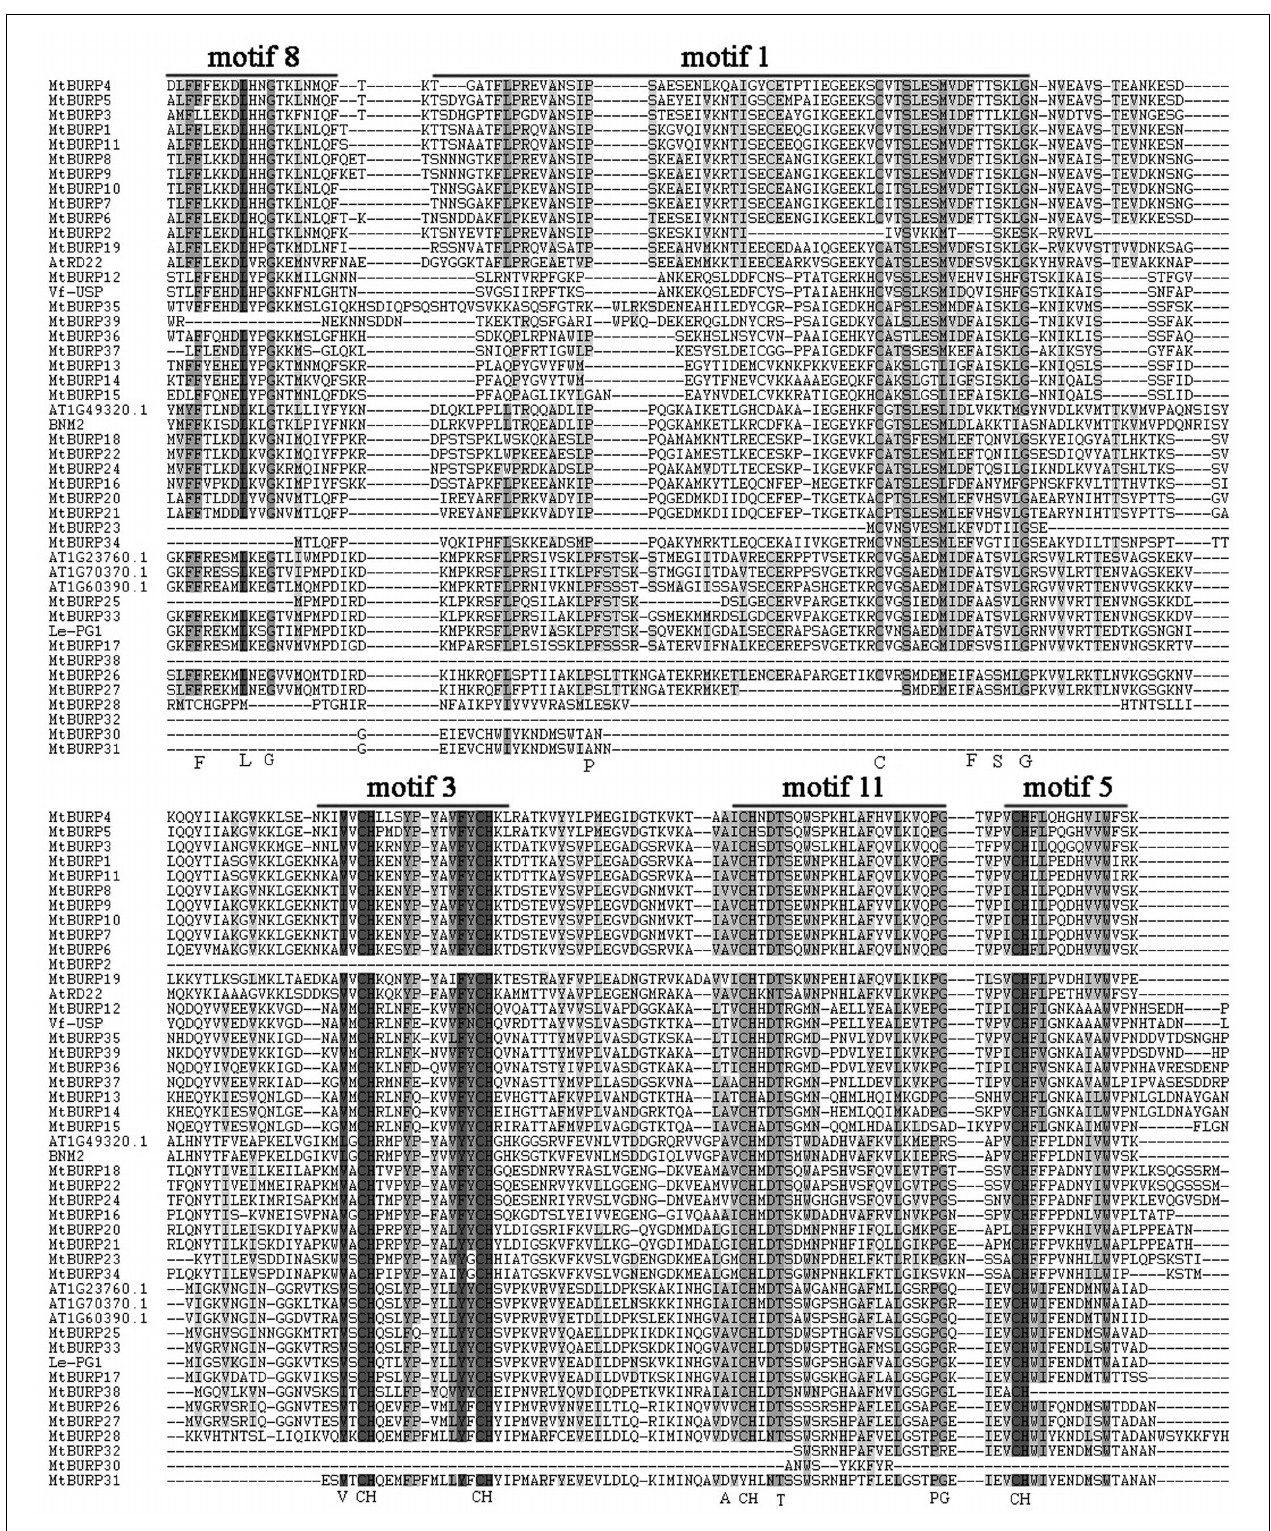
FIGURE 6 | Multiple alignments of MtBURP domain-containing proteins. The complete amino acid sequences of 39 MtBURP proteins and eight representative BURP proteins were aligned using Clustal X. Motif (n) represents the motifs identified in Medicago truncatula BURP proteins by MEME. Conserved domains are shaded in